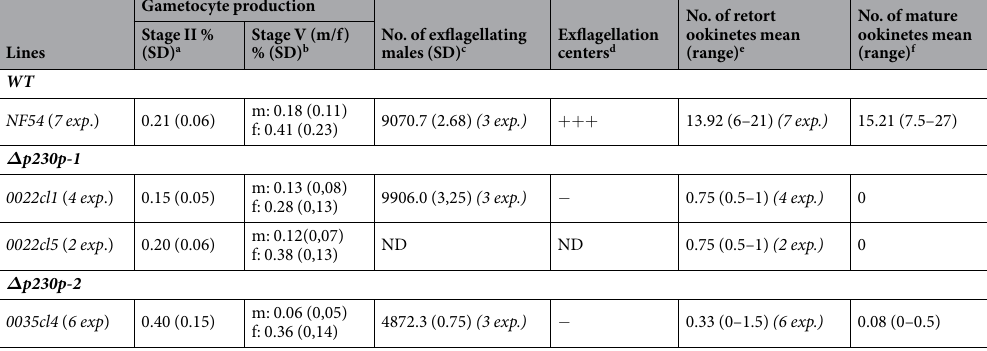
Table 1. Gametocyte production, gamete formation (exflagellation) and ookinete formation of WT and pf Δ p230p parasites. a Mean percentage of stage II gametocytes (per 100 red blood cells)in day 8 cultures in 2–7 experiments (exp.). b Mean percentage of stage V male (m) and female (f) gametocytes (per 100 red blood cells) in day 14 cultures in 2–7 experiments (exp.). c Mean number of exflagellating male gametocytes